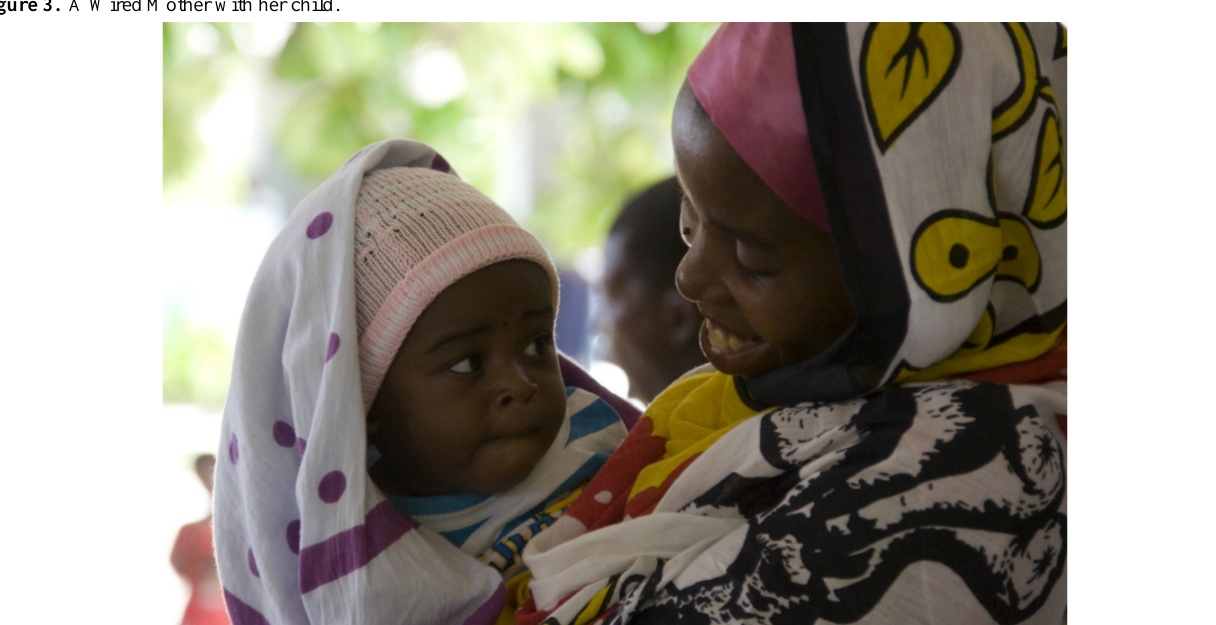
Figure 3. A Wired Mother with her